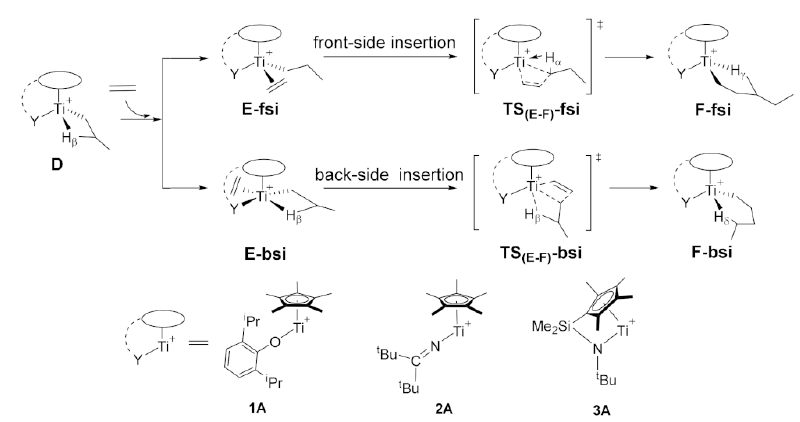
Figure 7. The proposed propagation process of ethylene polymerization catalyzed by half-titanocenes.